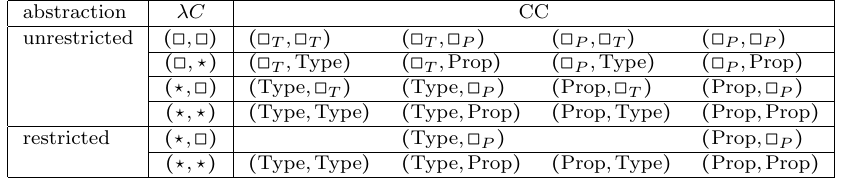
Fig. 18. The categories of abstractions in the